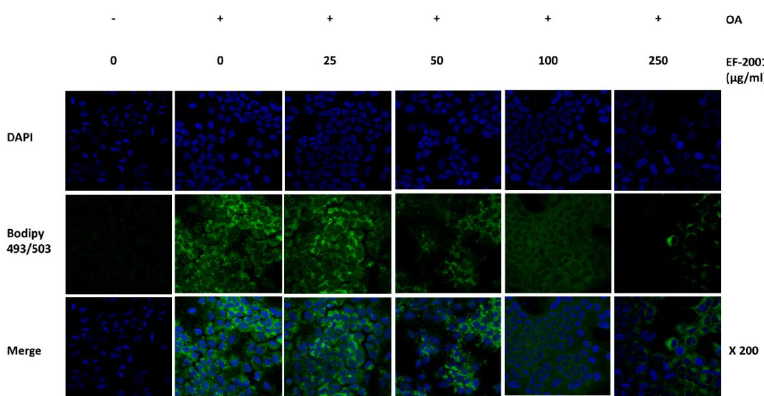
Figure 3. Effect of EF-2001 on confocal microscopy detection of neutral lipid droplet by BODIPY 493/507 in FL83B hepatocyte. FL83B hepatocyte lipid accumulation induced by 0.5 mM oleic acid (OA) for 48 h. FL83B hepatocyte media was changed in the presence of various doses of EF-2001 (0, 25, 50, 100, and 250 μg/mL) for 24 h. Neutral lipid was marked by BODIPY 493/503 (green), and nuclei were stained with 4′,6 -diamidino-2-phenylindole (blue). The stained neutral lipid was represented with confocal microscopy at ×200 magnification.